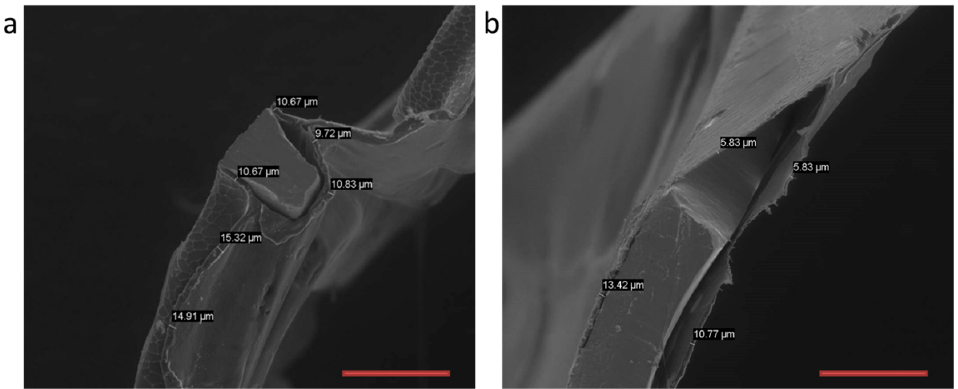
Figure 8. SEM micrographs of the stent: ( a ) Strut cross-section of the crimped stent; ( b ) Strut cross- section of the expanded stent. The thickness of the coating prior to and following expansion is also shown. (Scale bar: 200 μ m.).